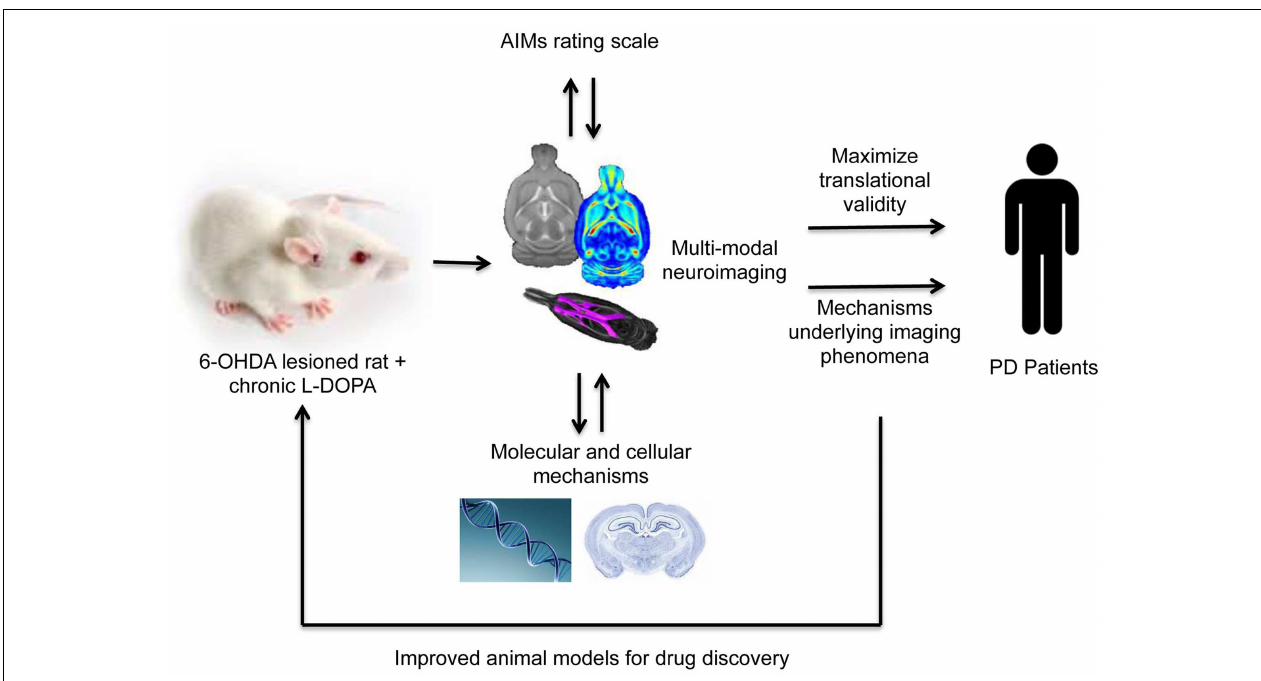
FIGURE 1 |A translational methodological framework for the combination of rodent models of LID (or these could be non-human primates) with multi-modal imaging, behavior and post-mortem cellular, or molecular analysis to elucidate the mechanisms underlying imaging phenomena associated with levodopa dyskinesia observed in human Parkinson’s disease patients